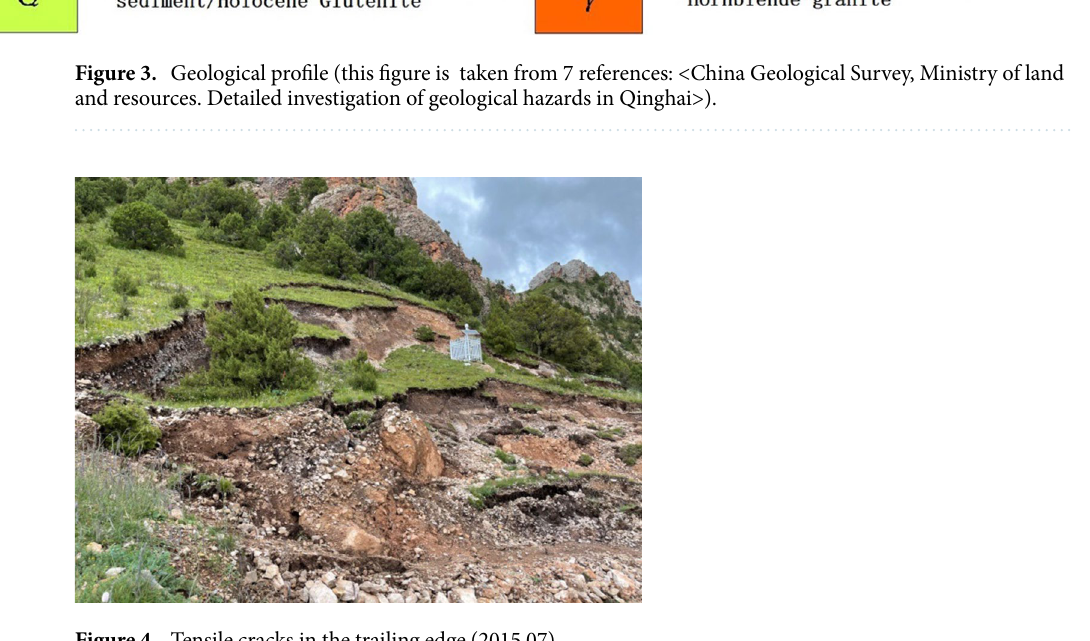
Figure 4. Tensile cracks in the trailing edge